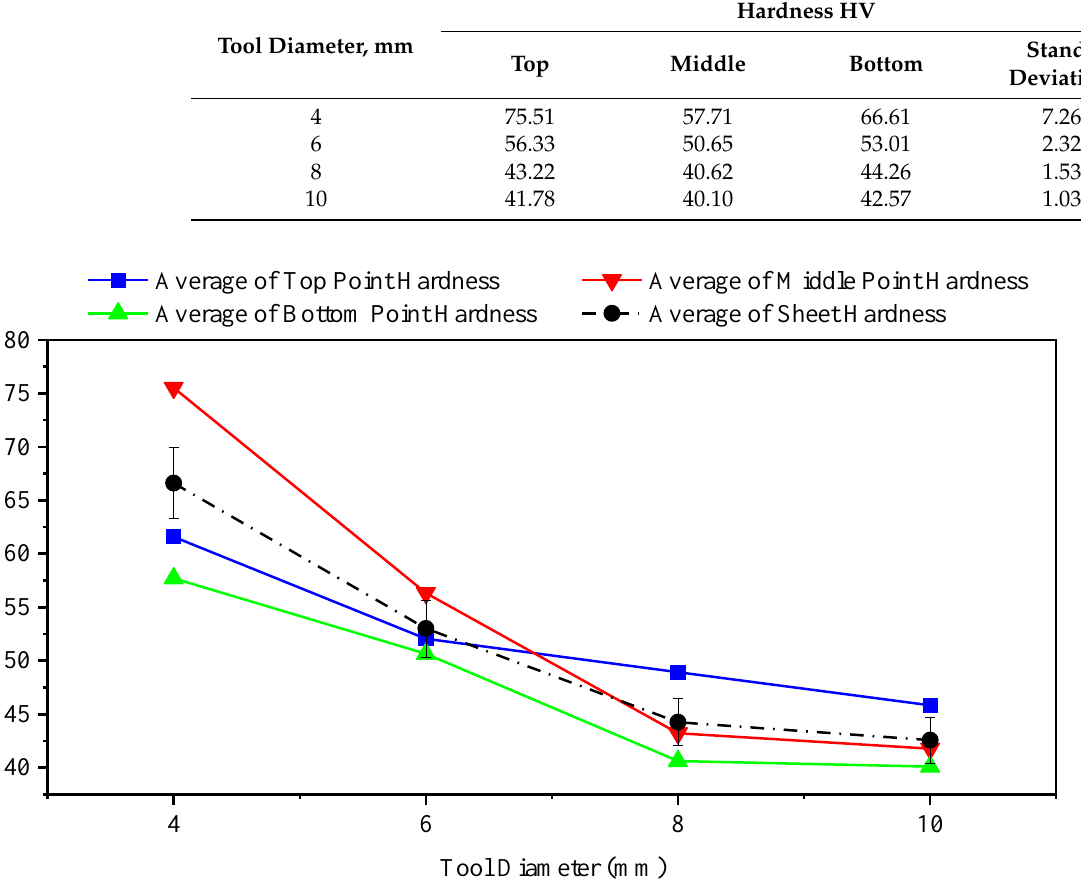
Figure 8. Effect of different tool diameters on hardness of formed sheet (feed rate: 600 mm/min; tool speed: 2000 rpm; coolant: oil).